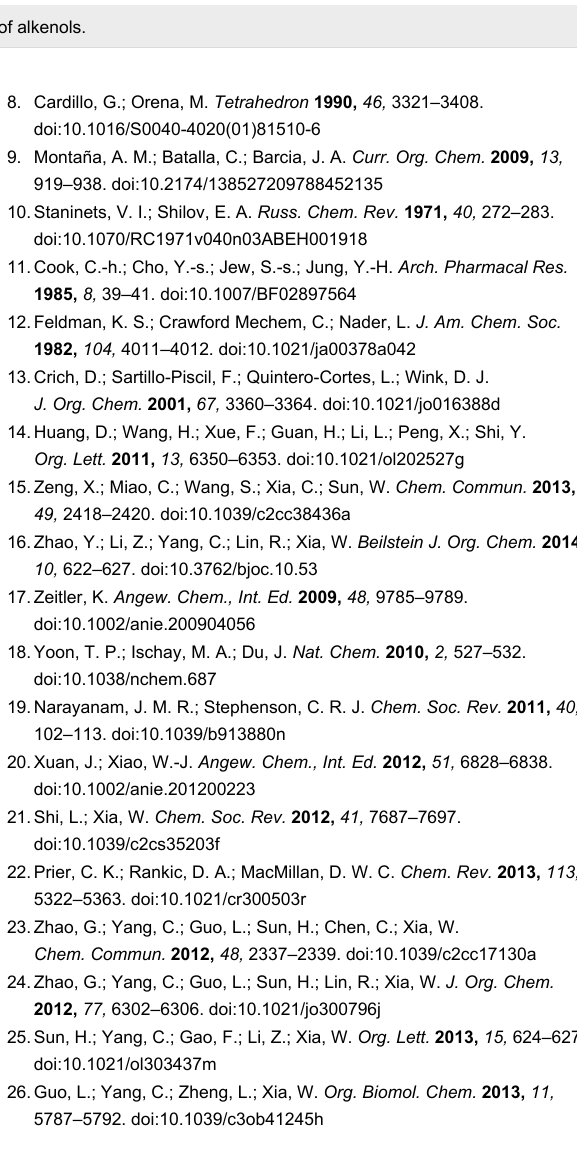
Scheme 2: Proposed mechanism for the photocatalytic bromoetherification of alkenols.